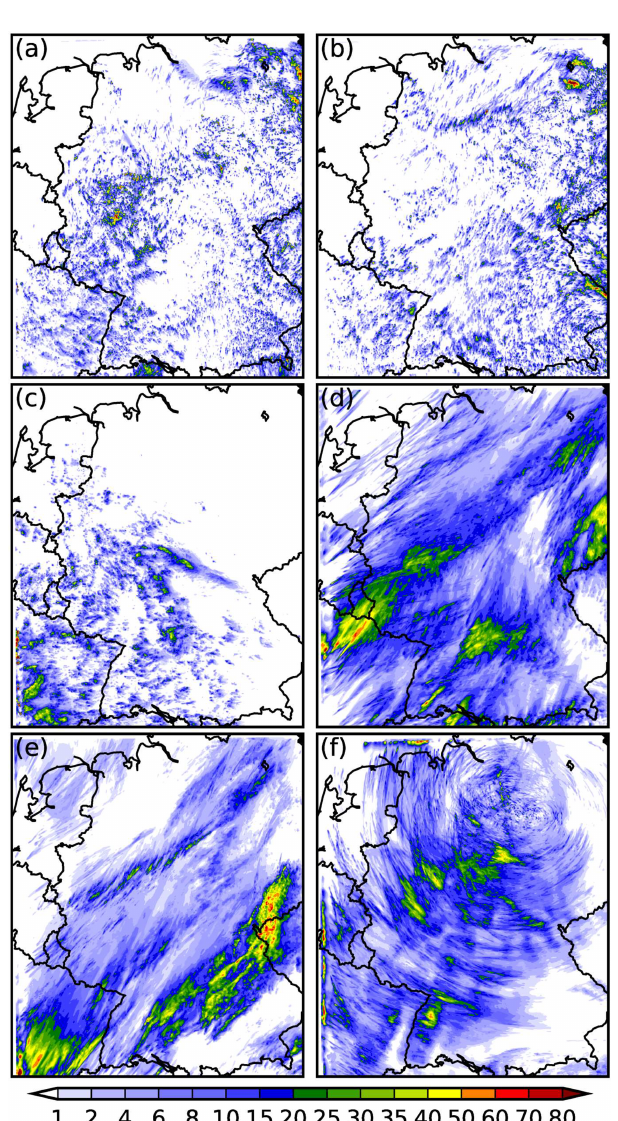
Figure 3. 24h precipitation amount of the 500m grid-length reference run in millimeters for the 6 days of investigation: (a) 30 June 2009; (b) 1 July 2009; (c) 23 July 2013; (d) 11 Septem- ber 2011; (e) 28 July 2013; (f) 11 September 2013. Figure adapted from Fig. 5 in Schneider et al.